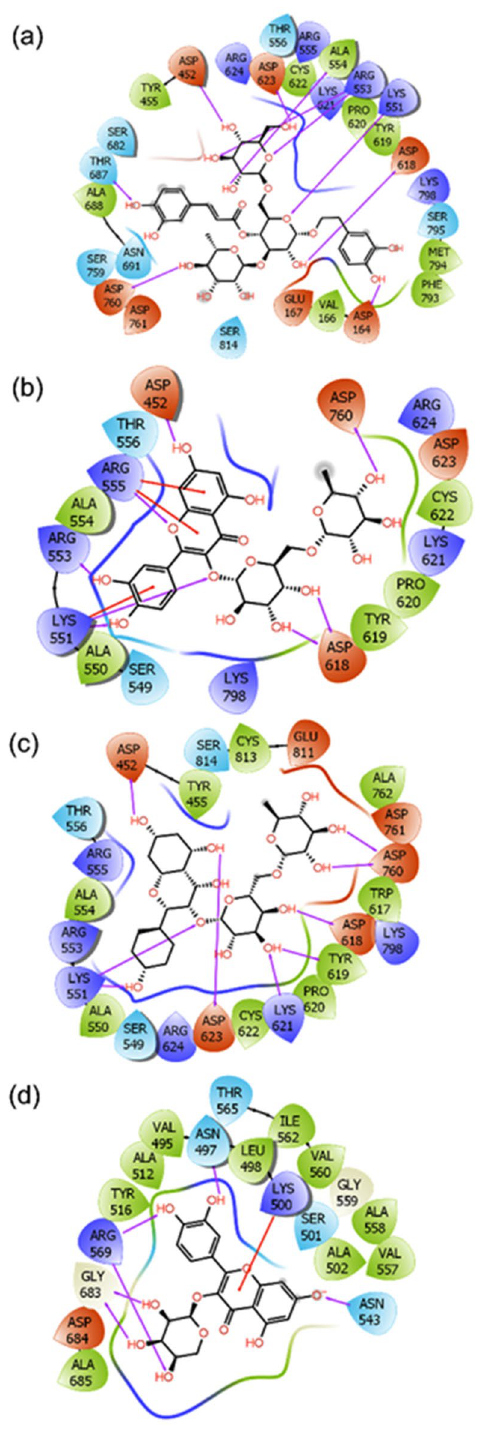
Figure 6. 2D molecular contact profiling for the re-docked poses of SARS-CoV-2 Rdrp with selected phytochemicals from selected plants, viz. ( a ) SARS-CoV-2 RdRp-Echinacoside, ( b ) SARS-CoV-2 RdRp-Rutin, ( c ) SARS-C0V-2 Rdrp-Kaempferol-3-O-rutinoside, and ( d ) SARS-CoV-2 Rdrp-Quercetin-3-o-xyloside. These poses exhibited hydrogen bond (pink arrows), π–π (green lines), hydrophobic 55 , polar (blue), negative (red), positive (violet), and glycine (grey) intermolecular interactions for the respective docked